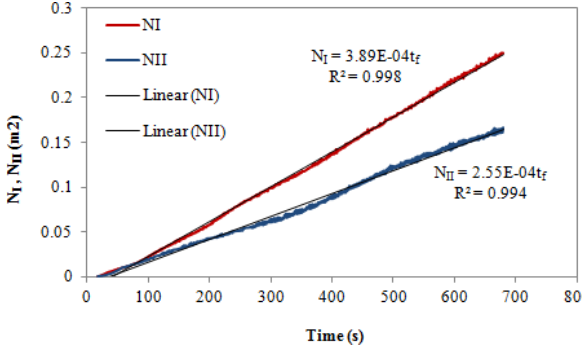
Figure 8: N I and N II versus the elapsed time